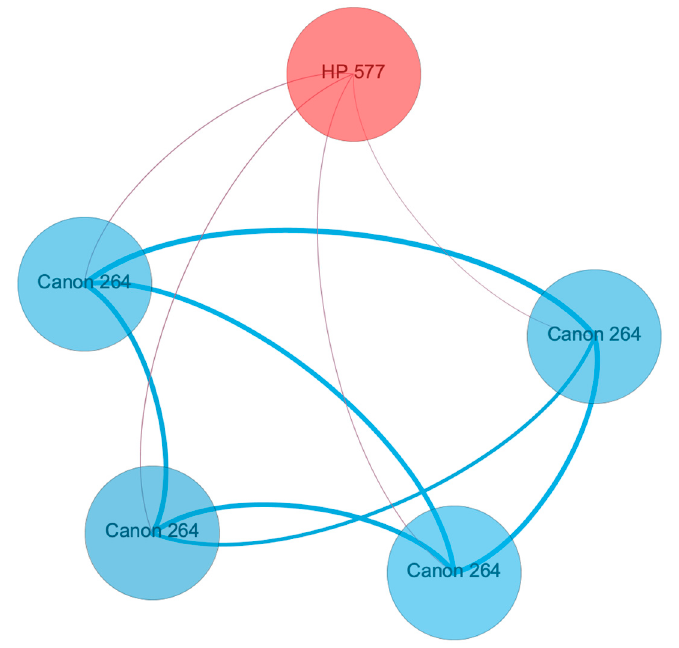
Figure 8. Test 3, which shows if a document is partially forged in one of its parts using the algorithm proposed in [32]. The four blue nodes re fl ect the original document, while the red node represents the forged part.